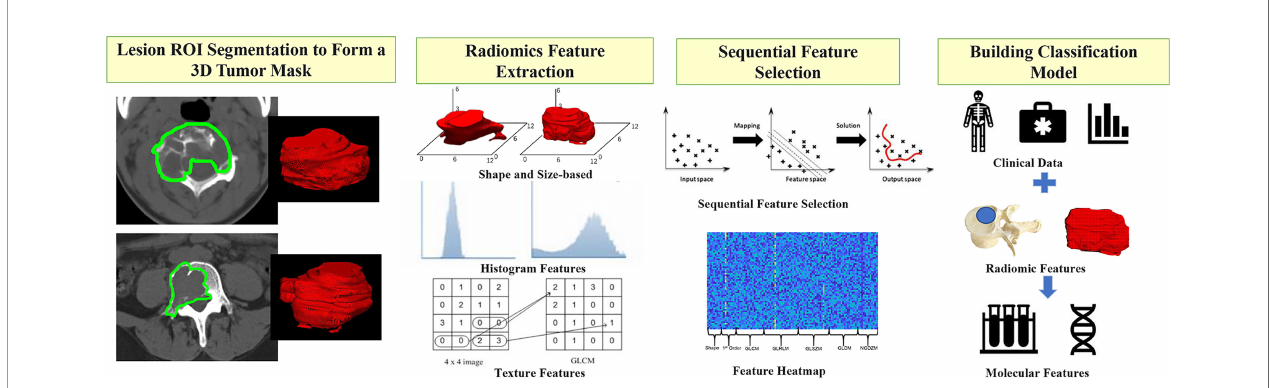
FIGURE 4 | The radiomics analysis procedures to build the classi fi cation model. Step1: The lesion ROI is outlined on each slice and then combined into a 3D tumor mask. Step 2: PyRadiomics is applied to extract 107 features, including shape, fi rst-order statistics, and texture from each tumor mask (GLCM is an example of a feature processing). Step 3: The sequential feature selection is performed by using SVM, and fi nally, Step 4: The SVM algorithm is applied to build the classi fi cation